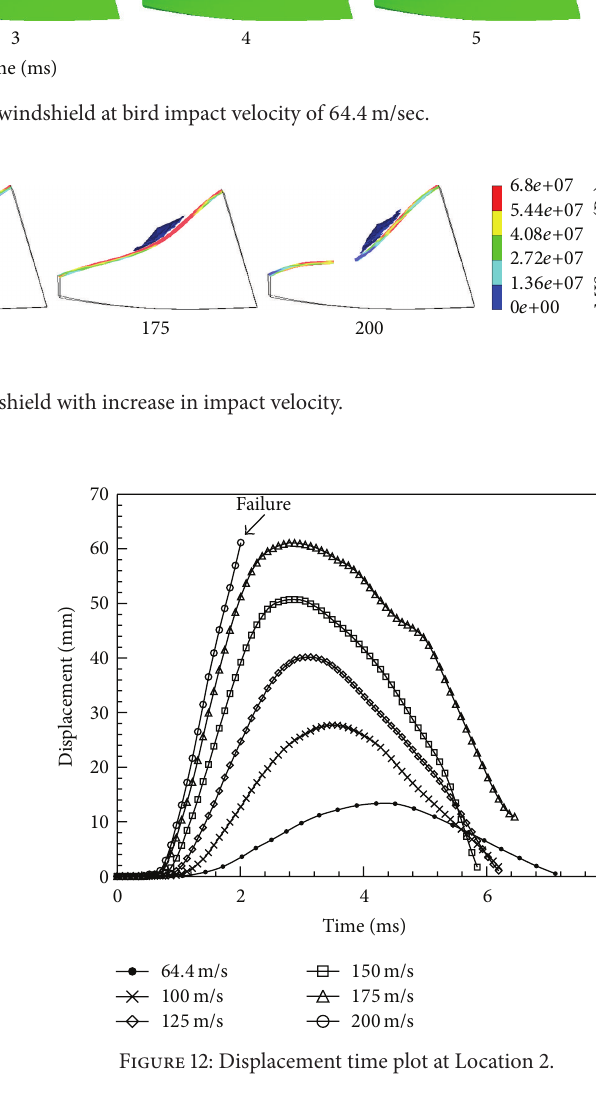
Figure 11: Response of windshield for different bird shapes.